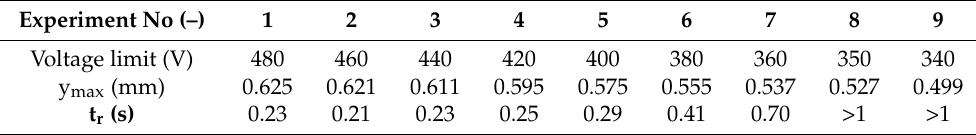
Table 4. Values of parameters in experiments with control voltage limits for one-input actuator.